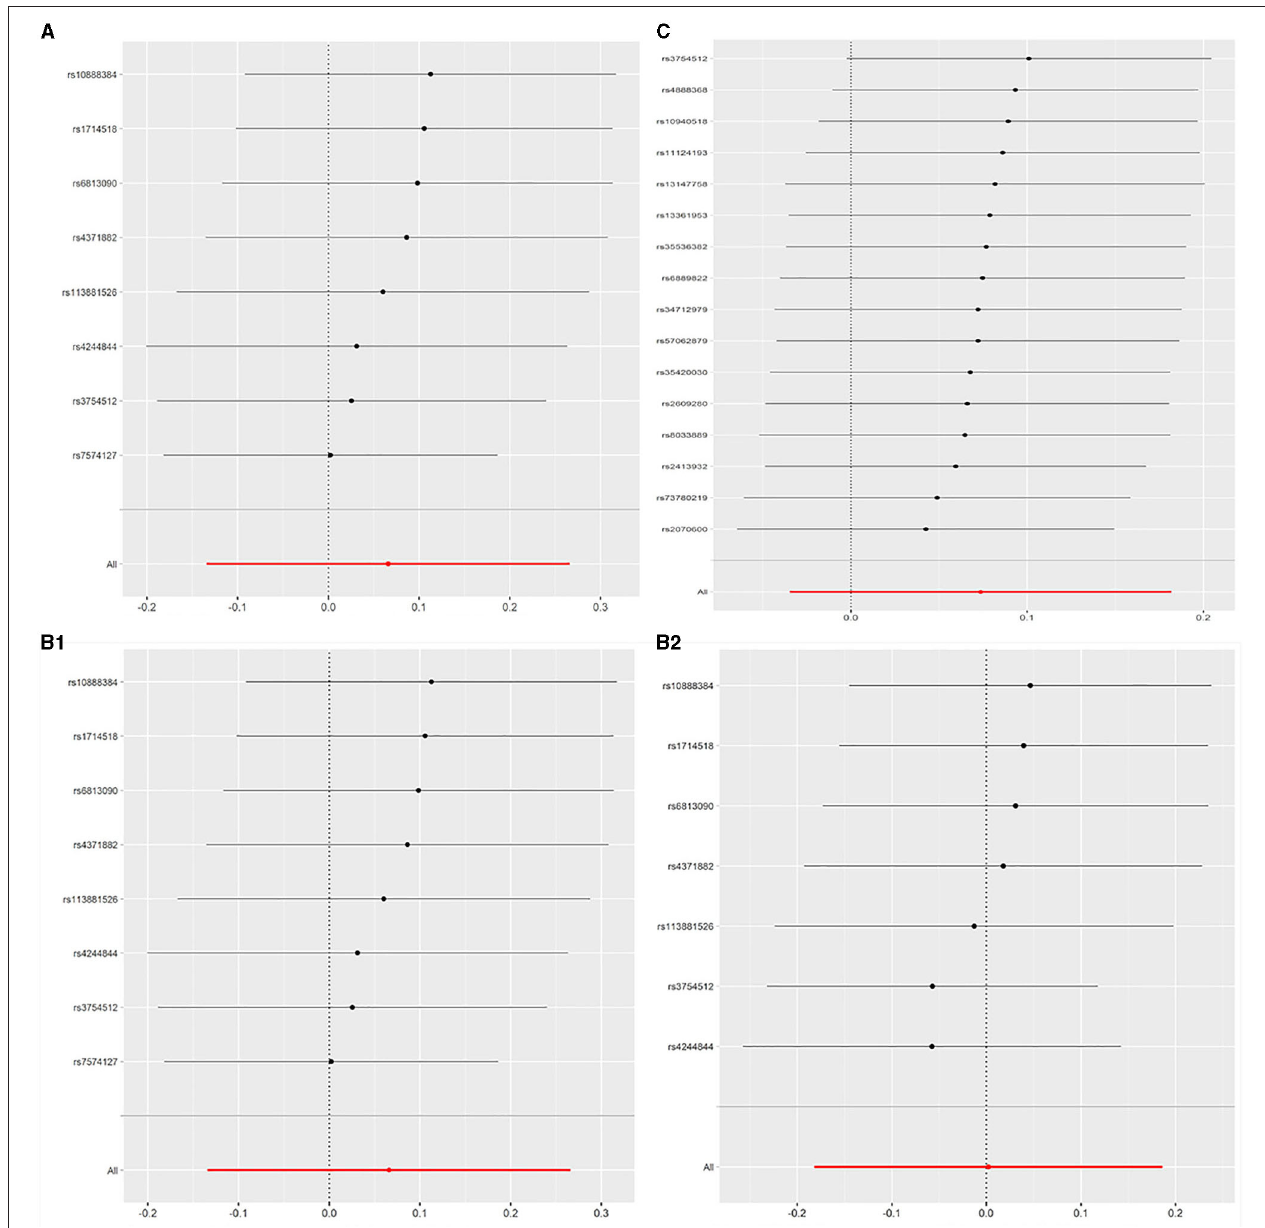
FIGURE 2 | (A) Leave-one-out plot: MR sensitivity analysis for FEV1 on AF. (B1) Leave-one-out plot: MR sensitivity analysis for FVC on AF (not removing the outlier SNP). (B2) Leave-one-out plot: MR sensitivity analysis for FVC on AF (removing the outlier SNP). (C) Leave-one-out plot: MR sensitivity analysis for FEV1/FVC on AF. Each row is interpreted as a Mendelian randomization analysis of the causal effects of FEV1 (A) , FVC (B) , and FEV1/FVC (C) on AF using the remaining instrumental variables other than the SNP listed on the y-axis. The dots represent the odds ratio after removing the corresponding SNP, and the lines represent corresponding 95% confidence interval. FEV1, forced expiratory volume in one second; FVC, forced vital capacity; FEV1/FVC, the ratio of FEV1 over FVC; AF, atrial fibrillation; SNP, single nucleotide polymorphism.